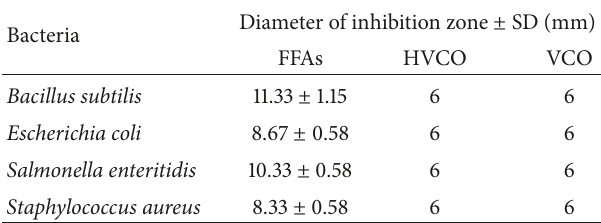
Table 1: Diameter of inhibition zone on 4 types of bacteria.